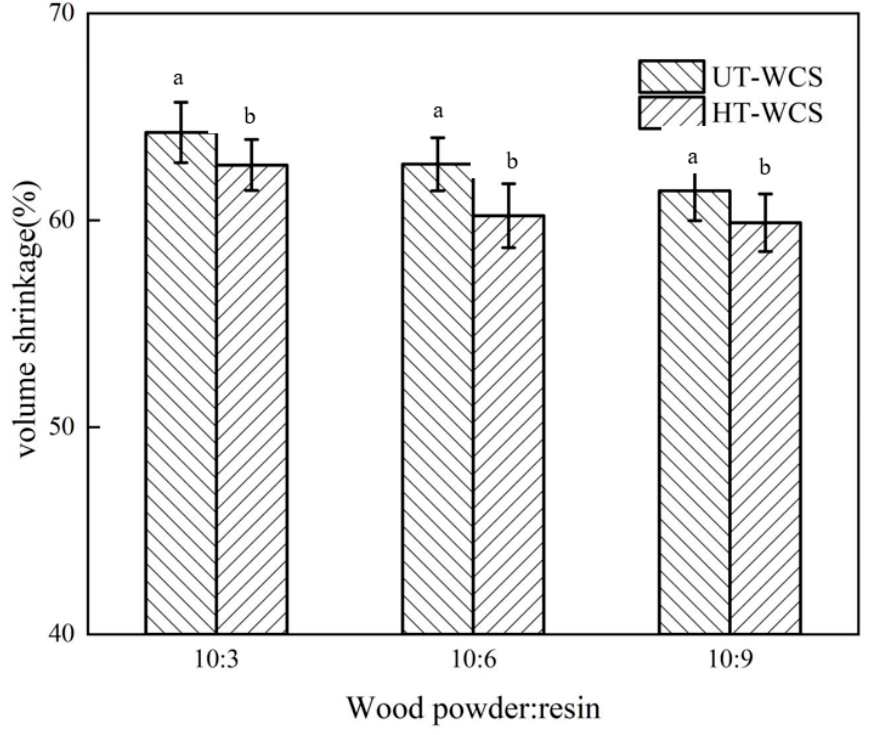
Figure 4. ( a ) The volume shrinkage of UT-WCS; ( b ) The volume shrinkage of HT-WCS. Different letter ( a , b ) indicate significant di ff erence between volume shrinkage (%) at 99% confidence level. As the proportion of phenolic resin increased, the carbon yield of WCS increased, and the volume shrinkage decreased, as shown in Figure 1. When the ratios of wood powder/resin were 10:3, 10:6 and 10:9, the carbon yield ratio of WCS made from untreated wood (UT-WCS) was 33.65%, 35.74% and 36.31%, respectively. The carbon yield ratio of WCS made from untreated poplar wood increased by 6.2% as the ratio of wood powder/phenolic resins increases from 10:3 to 10:6, increased by 1.6% as the ratio of wood powder/phenolic resins increases from 10:6 to 10:9. The carbon yield ratios of WCS made from heat-treated wood (UT-WCS) were 34.62%, 40.45% and 40.88%. When the ratio of wood powder/phenolic resin increased from 10:3 to 10:6, the carbon yield increased by 16.8%. When the ratio of wood powder/phenolic resin increased from 10:6 to 10:9, the carbon yield increased by 1.1%. Compared to UT-WCS, the carbon yield of WCS made from heat-treated wood (HT-WCS) had the same increasing tendency and higher carbon yield. This can be seen from the TGA of heat- treated wood due to its relatively increased content of lignin. For UT-WCS, when the ratios of wood powder/resin were 10:3, 10:6 and 10:9, the volume shrinkage ratio was 64.25%, 62.71%, 61.43%, respectively. The volume shrinkage ratio decreased by 2.4% as the ratio of phenolic resins increases from 10:3 to 10:6 and 2% as the ratio of phenolic resins increases from 10:6 to 10:9, respectively. For HT-WCS, the volume shrinkage ratios were 62.67%, 60.22%, 59.88%, respectively. The volume shrinkage ratio decreased by 3.9% as the ratio of phenolic resins increases from 10:3 to 10:6 and 0.6% as the ratio of phenolic resins increases from 10:6 to 10:9, respectively. The volume shrinkage of WCS mainly accounted for the decomposition of wood powder, resin and the formation of carbon/carbon composite. The higher the content of wood powder, the higher the volume shrinkage. Moreover, the volume shrinkage rate of UT-WCS was higher than that of HT-WCS. This is because untreated wood is more gasified than heat-treated wood, which can be proved by the TG graph. ANOVA test results indicated that there was a significant difference between the carbon yield and volumetric shrinkage of untreated and heat-treated of WCS at the 99% confidence interval ( p < 0.01). Duncan’s test classified the value of the carbon yield and volumetric shrinkage into two groups (Figures 3 and 4). Considering the change rate of carbon yield and volume shrinkage with increasing wood powder/resin ratio from